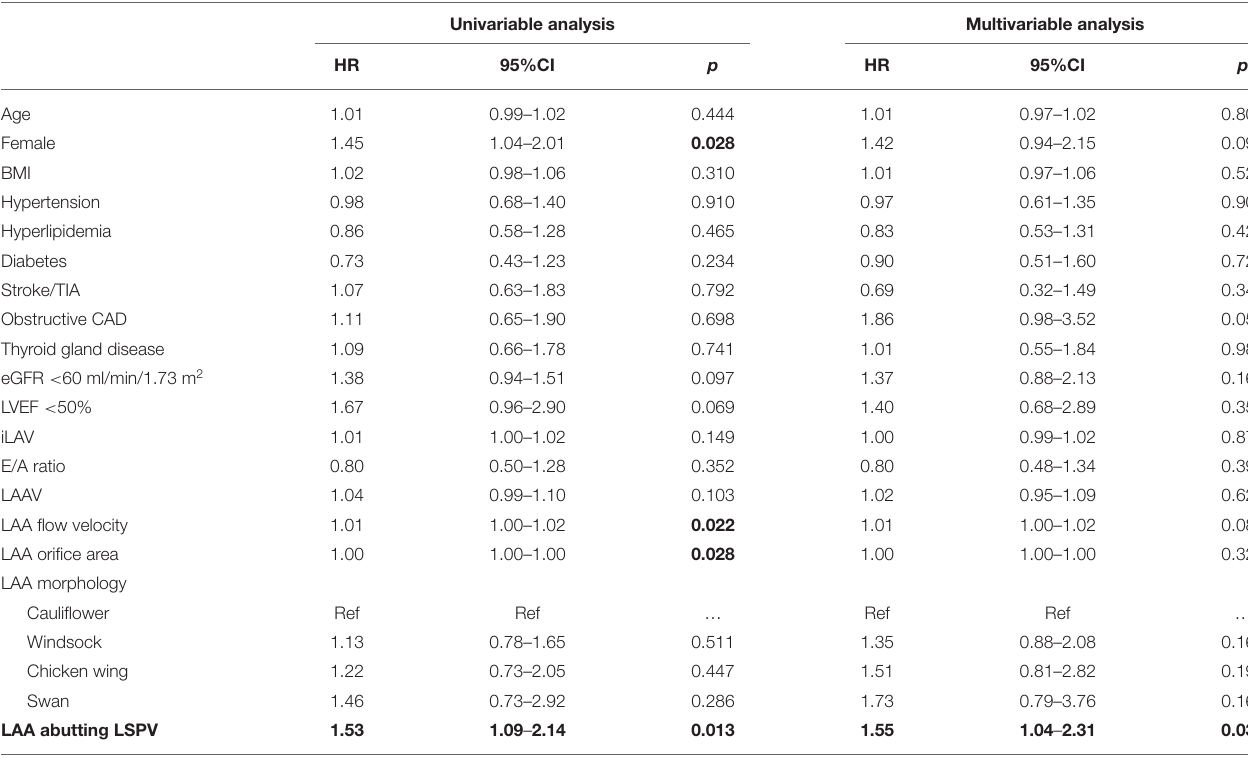
TABLE 2 | Predictors of atrial fibrillation recurrence in the overall patient